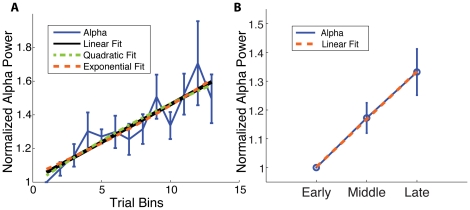
Within-Session Increase in Total Alpha Power.
A) Within-Session Increase in Binned Total Alpha Power. The group average of binned alpha power is fitted to a linear (black), quadratic (green), and exponential (orange) model. Blue Trace: Average alpha power (7–14 Hz, mean and standard error (S.E.), n = 12 subjects) from the hand area in SI across the experiment that has been divided into bins of 50 trials. For each subject, alpha power was normalized to the earliest bin average. No significant improvement beyond linear model is seen. (Linear fit: R2 = 0.81, p = 0.03, one-sided t-test) B) Within-Session Increase in Expression of Total Alpha Power. Blue Trace: Average alpha power (7–14 Hz, mean and S.E., n = 12 subjects) from the hand area in SI across three blocks of the experiment (early (E), middle (M), and late (L) trials). For each subject, alpha power was normalized to the early block (E) average. Linear regression analysis (orange dash) confirmed a statistically significant increase in total alpha power across the experimental session (R2 = 0.99, p<0.01, one-sided t-test).